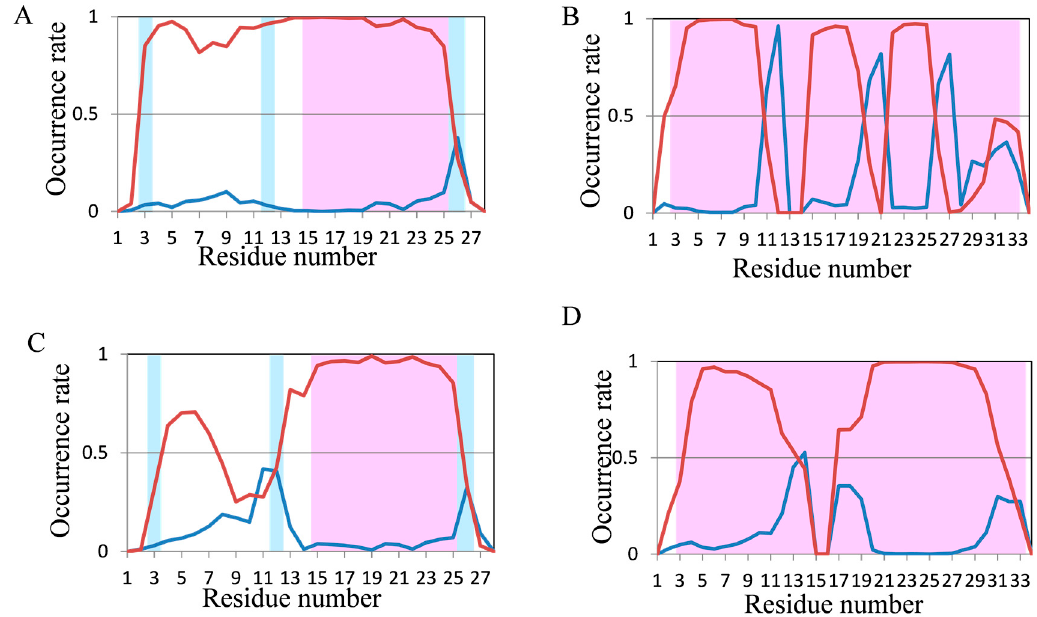
Figure 5. Analysis of the secondary structure formation in FSD-1 (28 residues) and HPH (34 residues) by normal MD simulations. The occurrence rate of secondary structures of ( A ) FSD-1; ( B ) HPH in 200-ns simulations and of ( C ) FSD-1, and ( D ) HPH in 2000-ns simulations. Color coding is the same as that in Figure 3.